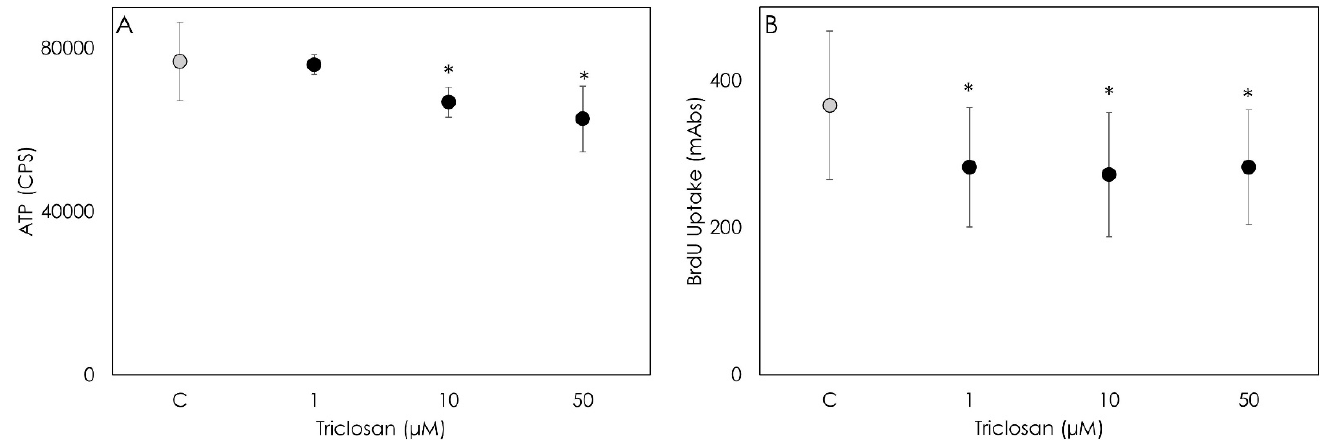
Figure 1. Result of ATP ( A ) and 5 ‐ bromo ‐ 2 ′ deoxyuridine (BrdU) ( B ) tests carried out on porcine granulosa cells following treatment with Triclosan (1, 10 or 50 μ M) for 48 h. The tests evaluate the metabolic activity and proliferation of treated cells, respectively. Data are expressed as counts per second (CPS) ( A ) and on milli ‐ Abs units ( B ) and represent the mean ± SD of six replicates/treatment repeated in five experiments (n = 30). Asterisks on points indicate that data show significant differences ( p < 0.001).